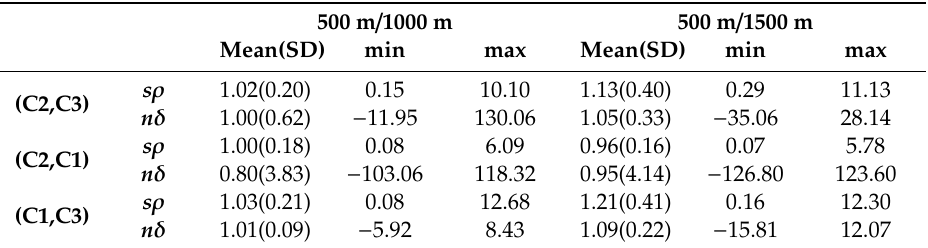
Table 7. The mean, standard deviation, min, and max values of each image from Figures 9–11. Note, that all images for this comparison were derived from single returns.